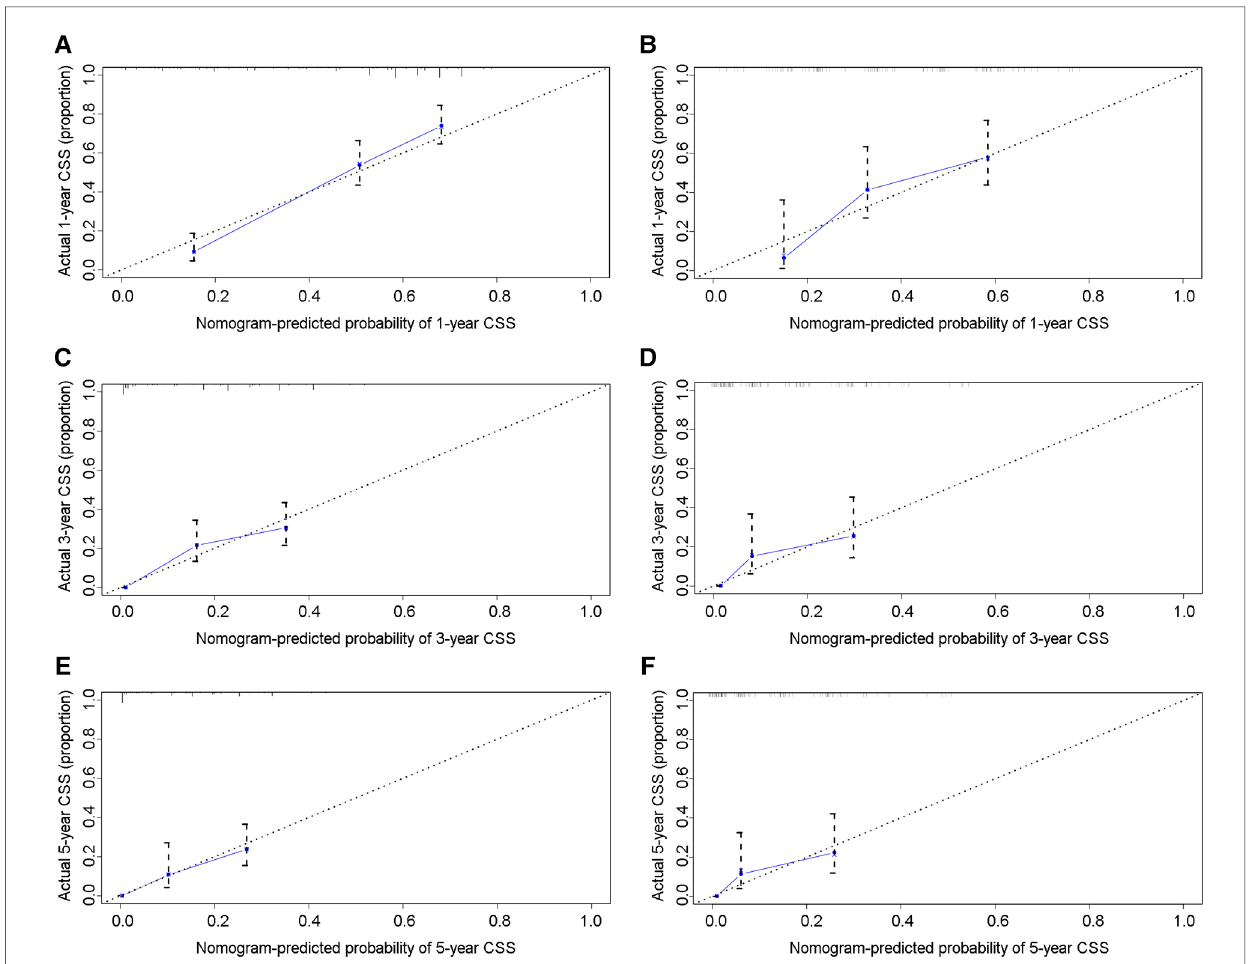
FIGURE 5 Calibration curves of the 1-, 3-, and 5-year CSS of NEPC patients. 1-year ( A ), 3-year ( C ), 5-year ( E ) CSS in training group; 1-year ( B ), 3-year ( D ), 5-year ( F ) CSS in validation